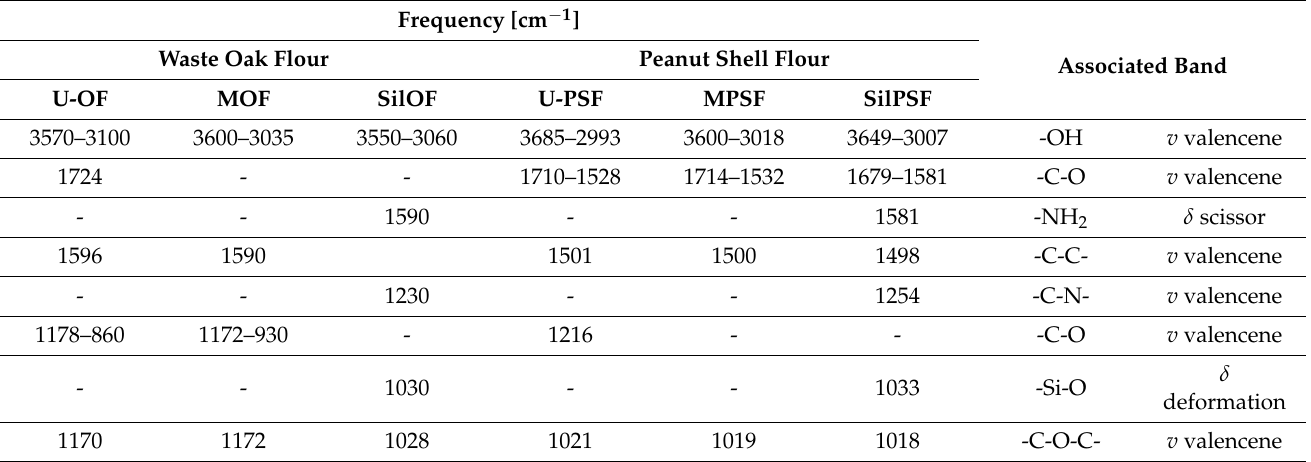
Table 1. FT–IR analysis of waste